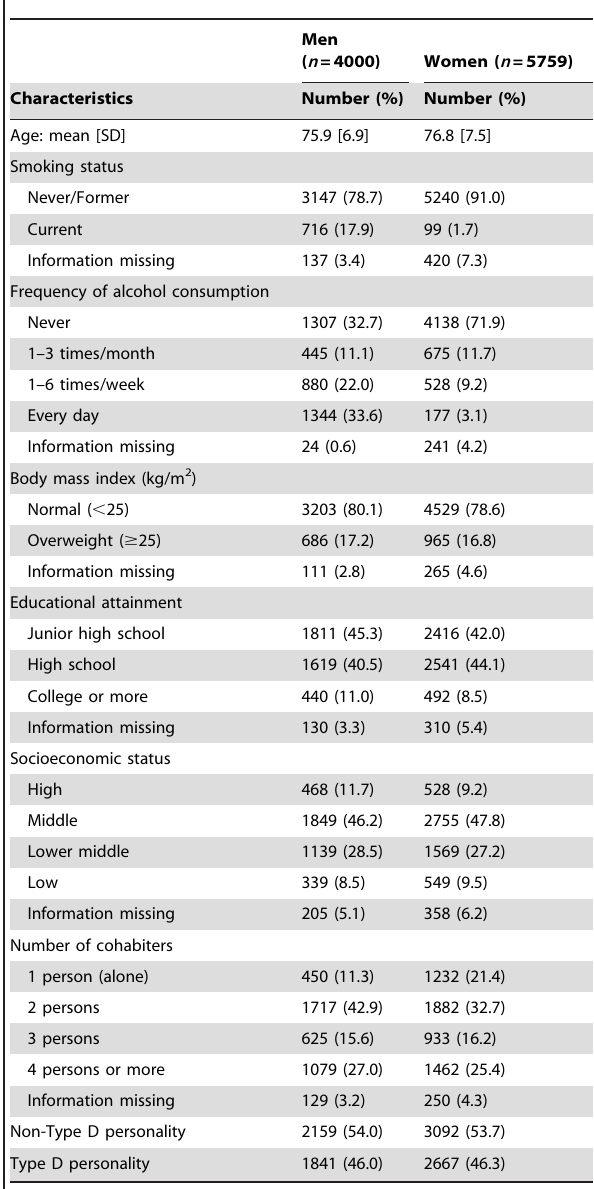
Table 1. Demographic characteristics of participants, Japan,